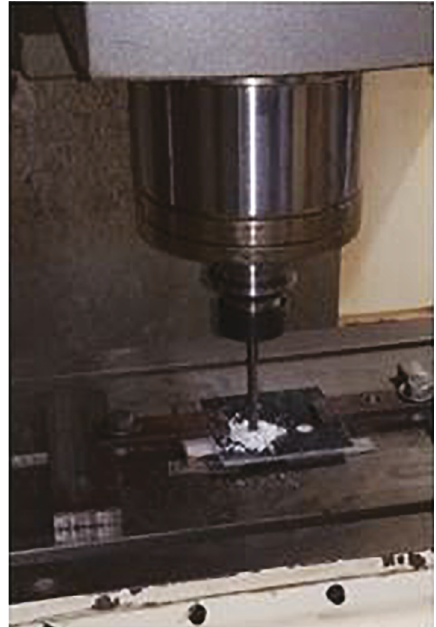
Figure 2: Experimental set-up.